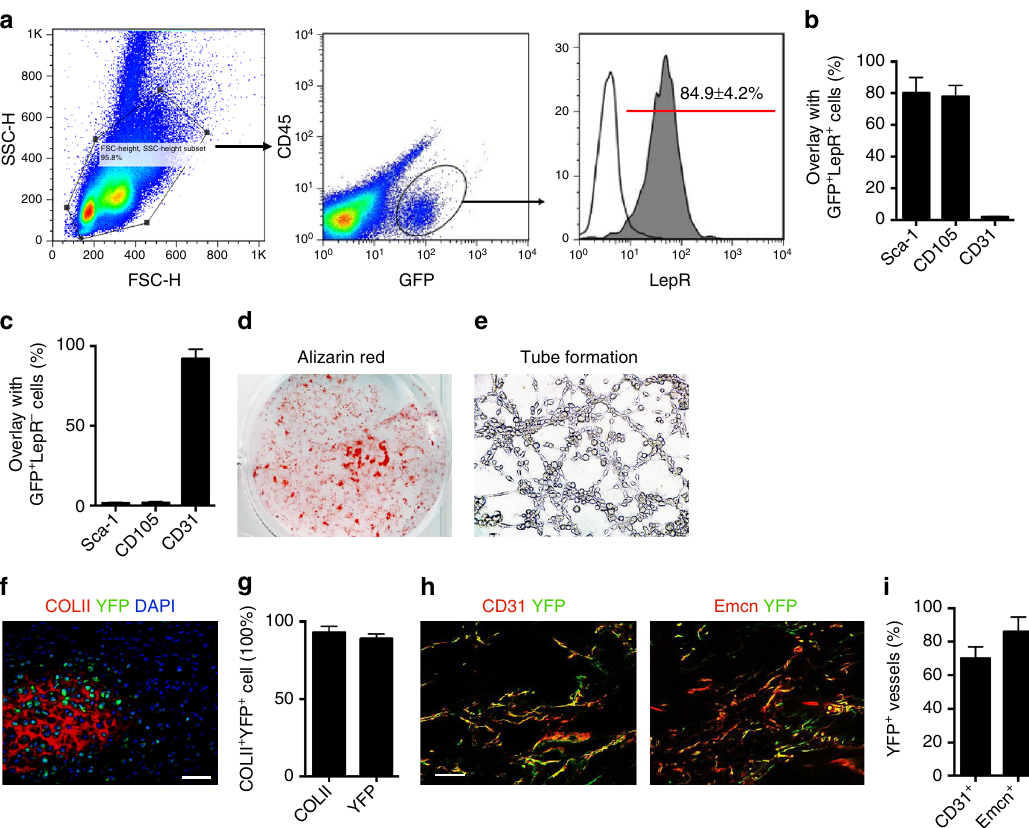
Fig. 6 Nestin + cells at the injured site are predominantly MSPCs. a The percentage of the CD45 - GFP + cells that express LepR. n = 16. b The percentages of the GFP + LepR + cells or c GFP + LepR − cells that express Sca-1, CD105, or CD31, respectively. d Alizarin red staining of GFP + cells cultured in osteogenic differentiation medium for 14 days and e tube formation of GFP + cells by Matrigel assay. f Immunostaining of COLII + cells (red) and YFP + cells (green) and g quantitation of Nestin-creERT2::EYFP fl ox/ fl ox mice 3 weeks post ATP. Scale bar, 50 μ m, n = 8 per group. h , left: CD31 + cells (red), YFP + cells (green), and right: Emcn + cells (red), YFP + cells (green), and i quantitation in ectopic bone marrow of Nestin-creERT2::EYFP fl ox/ fl ox mice 6 weeks post ATP. Scale bar, 100 μ m, n = 8 per group. All data are shown as the mean ±